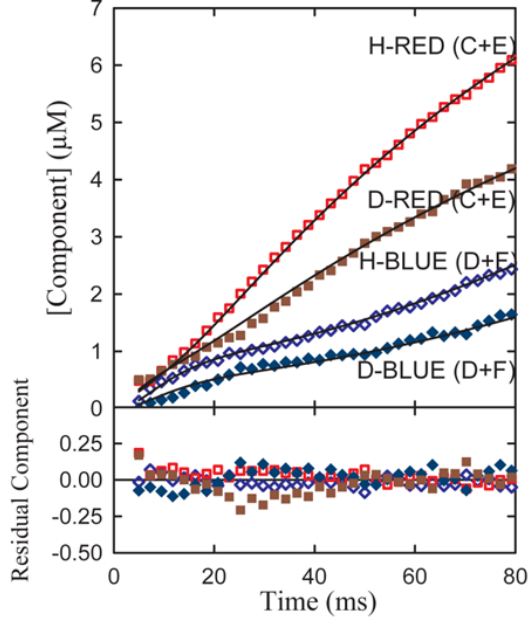
Figure 6. A simultaneous fit of all four components to both the h(protio) and d(deuterio) component time course of the resolved date of Figure 3 where C and D follow the sum of the red and blue components respectively. Red-shifted components are indicated by diamond shaped symbols and blue-shifted components by circles. Open symbols denote h-substituted components; closed symbols indicate d-substituted components